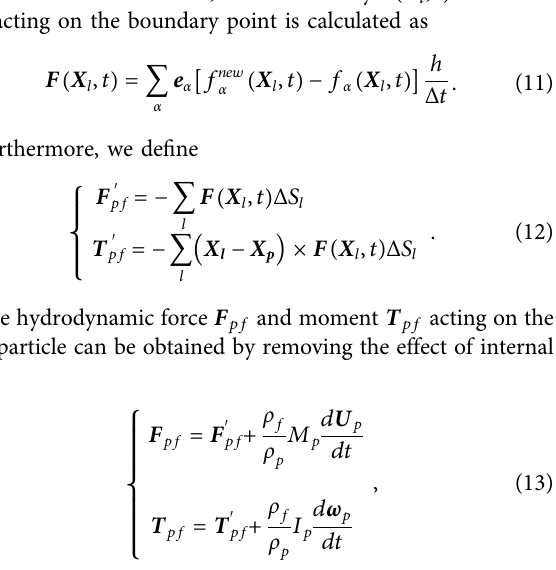
FIGURE 1 | Con fi guration of the grids used in the IBM. Euler points (circles) represent the fl ow fi eld and Lagrange points (crosses) represent the fl uid – solid